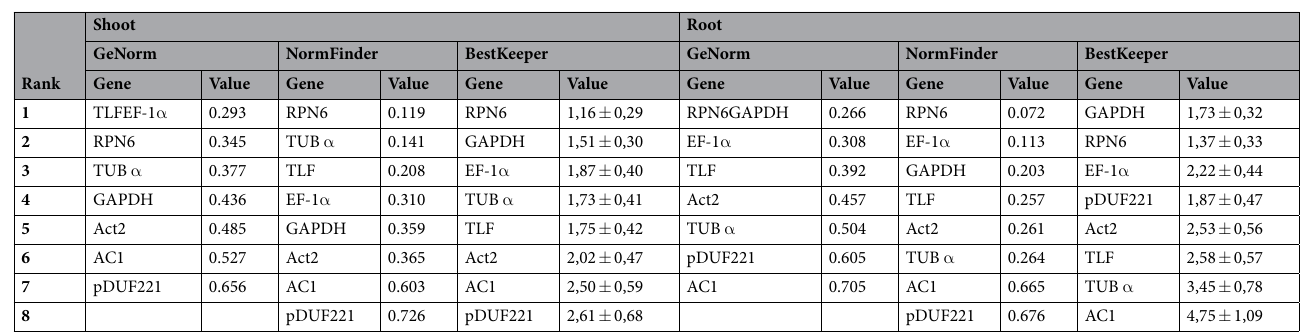
Table 3. Stability ranking of each candidate reference gene using different algorithms under osmotic stress in shoot and root. Column “value” corresponds to M in geNorm, S in NormFinder and CV ± SD in